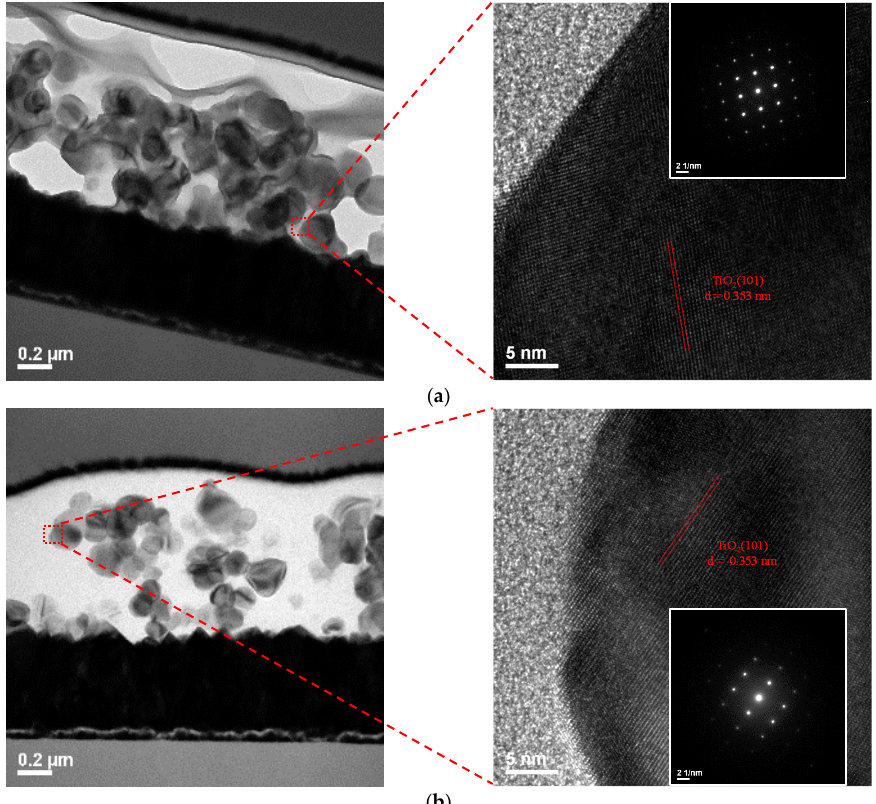
Figure 10. The cross-sectional and high-resolution TEM images for the 350 °C-annealed TiO 2 film prepared by injecting DMF doses of ( a ) 0 and ( b ) 7.5 wt%. The inserted image into the right side corresponds to the selected area electron diffraction images.